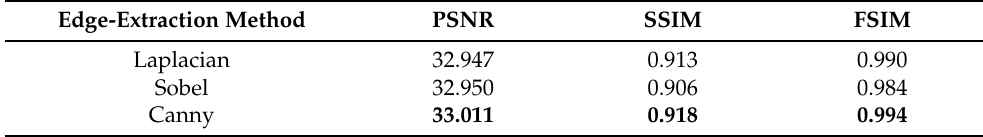
Table 3. Comparison of edge-extraction methods, where the best results are shown in